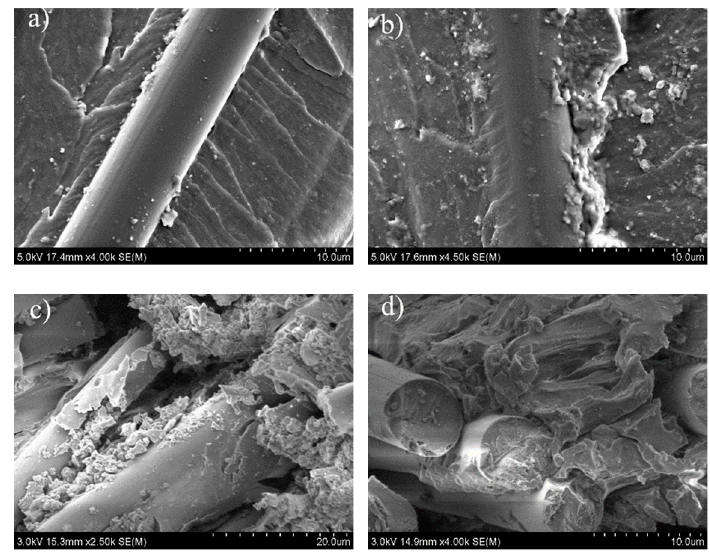
Figure 7. SEM analysis of NOL composite (10phr CSR / 2phr SiO 2 ): ( a , b ) SEM of interlaminar shear failure surface; ( c , d ) SEM of tensile fracture surface.